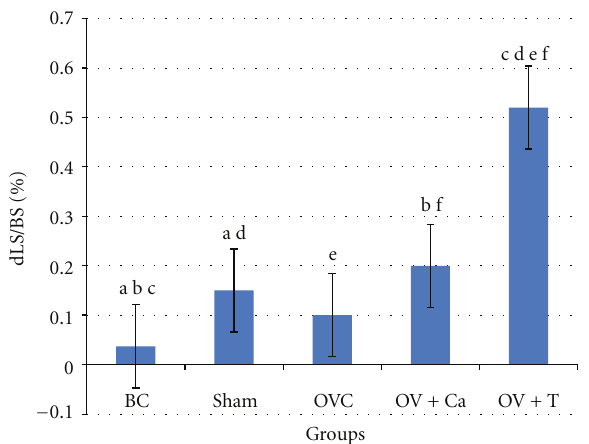
Figure 4: Mineral apposition rate (MAR). BC: baseline control group. Sham: sham-operated rats given deionised water and vehicle olive oil. OVC: ovariectomised rats given deionised water and vehicle olive oil. Ov+Ca: ovariectomised rats given 1% calcium in deionised water and vehicle olive oil. Ov+T: ovariectomised rats given deionised water and palm tocotrienol. Same alphabet indicates significant di ff erence between the groups ( P < 0 . 05).